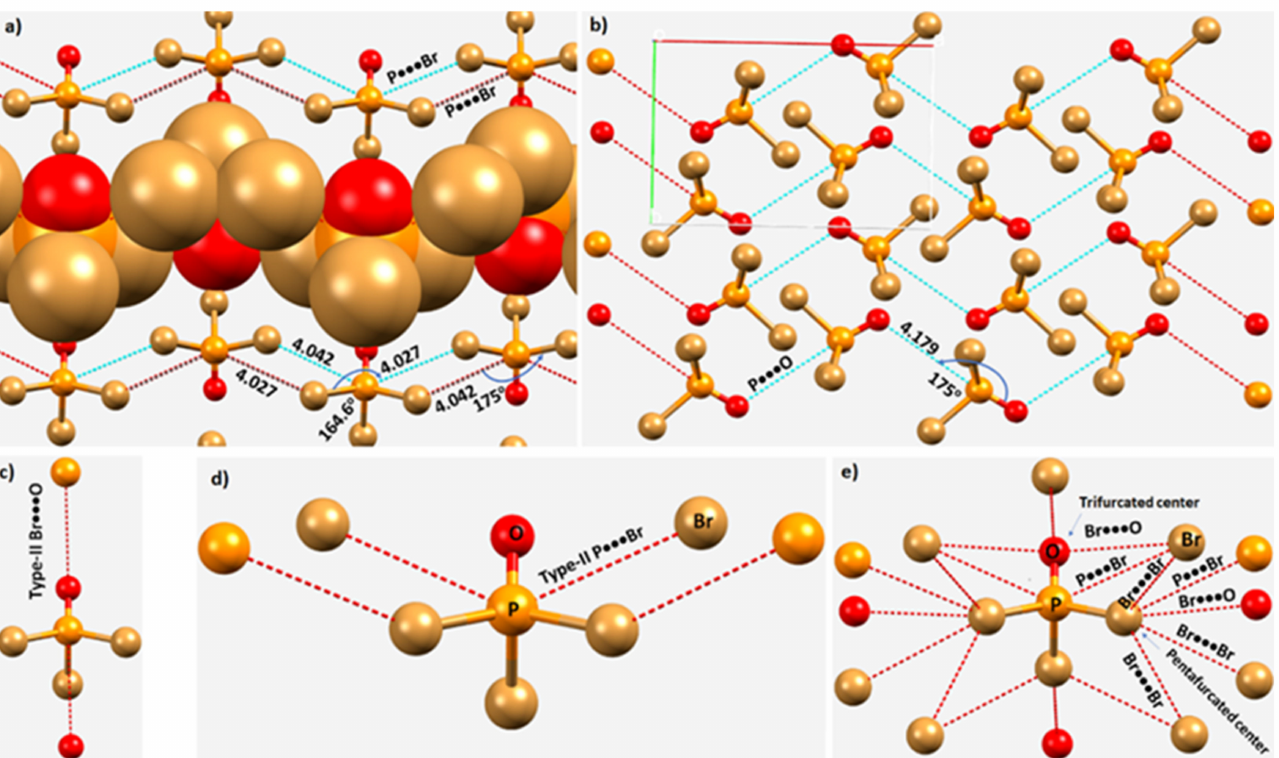
Figure 13. ( a , b ) The zig-zag nature of the P ··· Br and P ··· O interactions, respectively, in POBr. ( c , d ) Schematic representation of Type-II Br ··· O and P ··· Br interactions, respectively. ( e ) A tentative representation of the intermolecular interactions formed by each POBr 3 unit with the neighboring molecules in the crystal (ICSD ref. code 23243), marked by hanging dotted lines in red between atoms. Selected bond distances and bond angles are in Å and degrees,